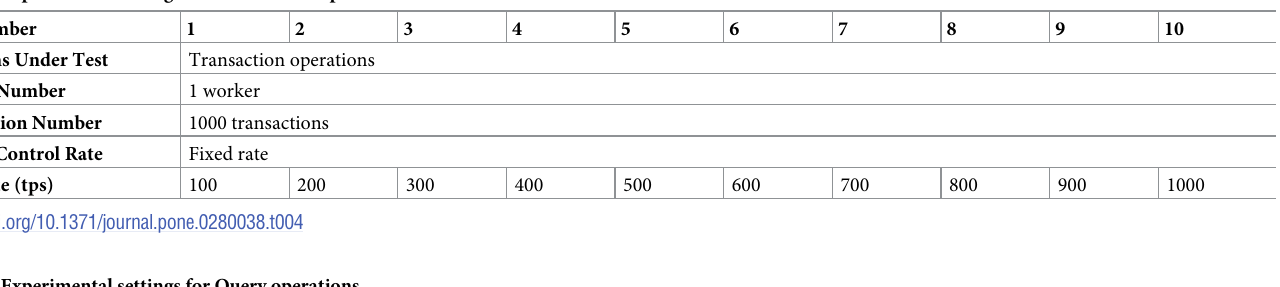
Table 4. Experimental settings for Transaction operations.